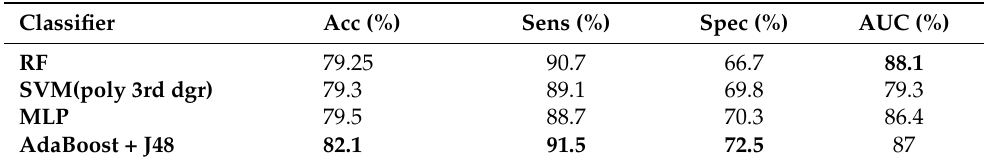
Table 6. The values of the classification performance parameters for texture analysis methods combined with conventional classifiers, obtained on CEUS